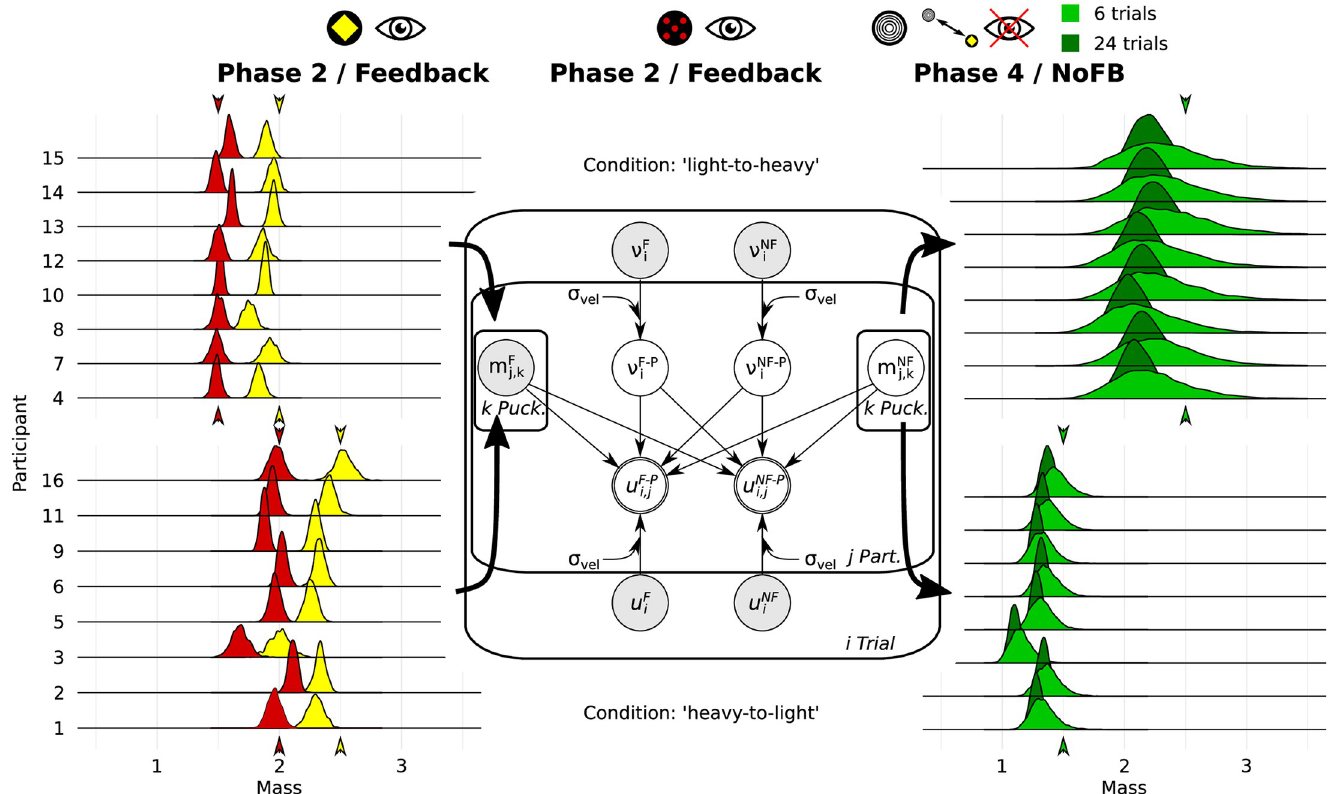
Fig 9. Bayesian model for learning through observing collisions with prior and posterior mass beliefs. The left panel shows inferred posterior mass beliefs for the pucks from feedback phase 2 for each participant. All 100 trials were used to infer the mass beliefs. These posteriors were used as priors for the inference from observations. The graphical model for learning by observing collision is shown in the middle panel. Uncertainty about the pucks’ velocities is introduced for the initial velocities v and v as well as for the resulting velocities u and u after the elastic collision. Utilizing the physical relationship of velocities and masses in an elastic F NF F NF collision enables inferring beliefs about the unknown puck based on previous mass beliefs of pucks in phase 2. Resulting posterior mass beliefs are shown in the right panel for inferences based on 6 and 24 observations of